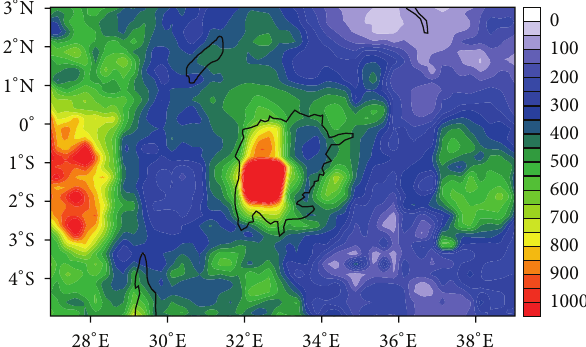
Figure 1: Tropical Rainfall Measuring Mission (TRMM) data showingthetotalrainfall(mm)overtheLVBbasinforthe1999short rains (OND). The asymmetrical pattern over the lake can be clearly